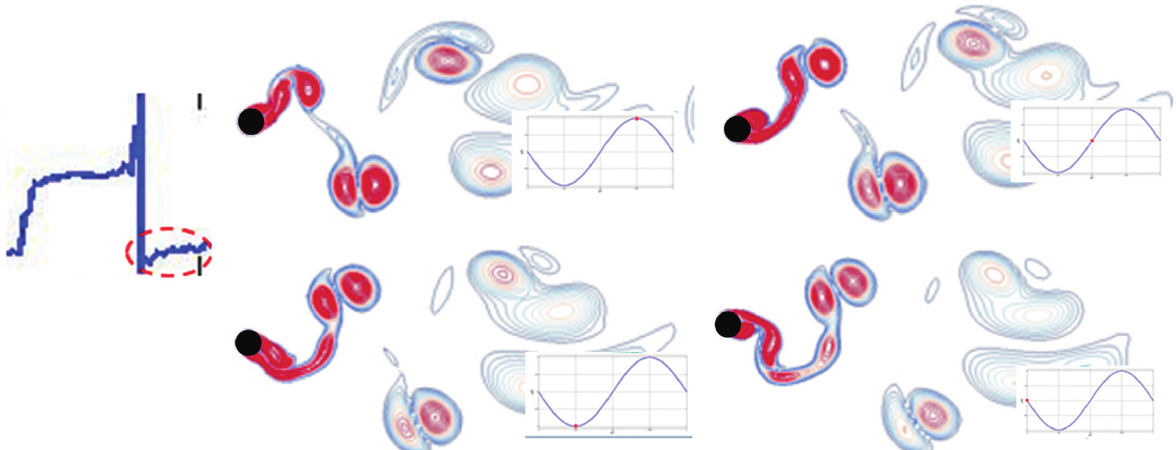
Figure 9: Vortex field of 2 P mode at the negative part of phase angle.